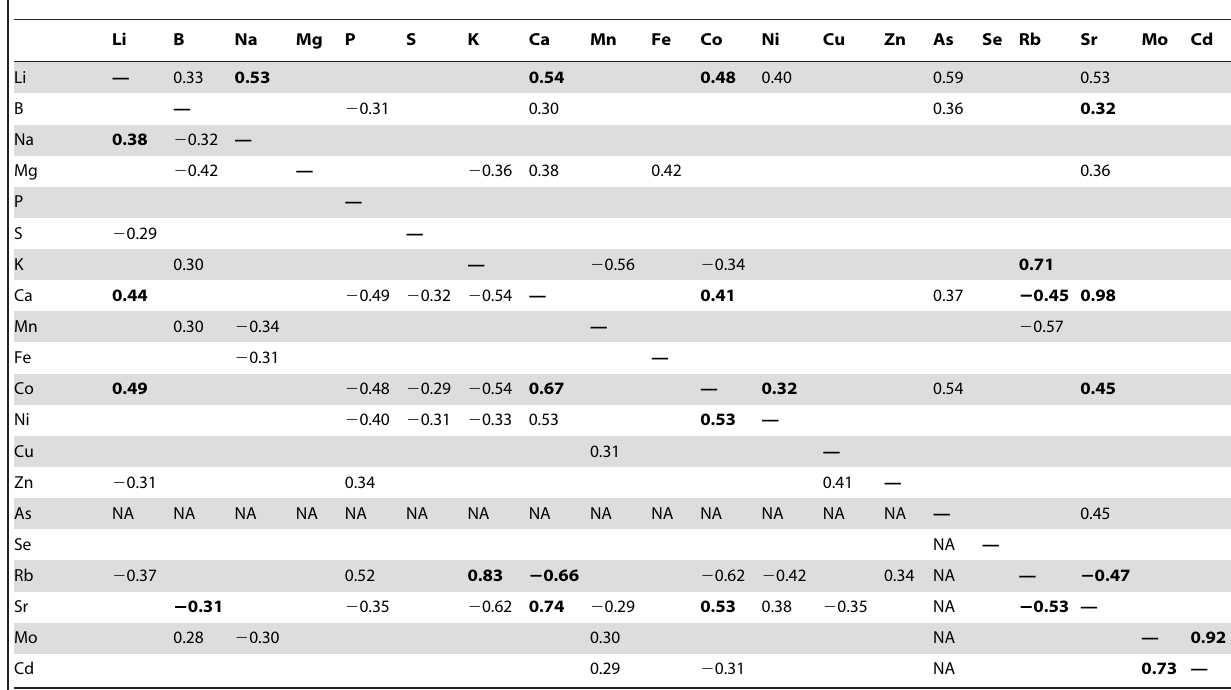
Table 2. Pearson product-moment correlation coefficients (r) between leaf elemental concentration traits in the RILs.